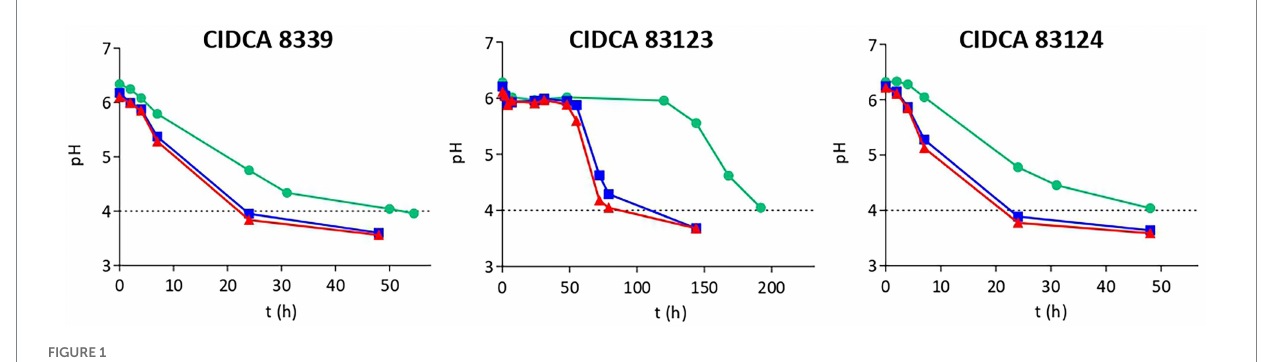
FIGURE 1 Acidification kinetics of Lacticaseibacillus paracasei CIDCA 8339, CIDCA 83123 and CIDCA 83124 in milk at 20 ° C ( ), 30 ° C ( ), and 37 ° C ( ). Dotted line indicates the pH selected for characterization of fermented